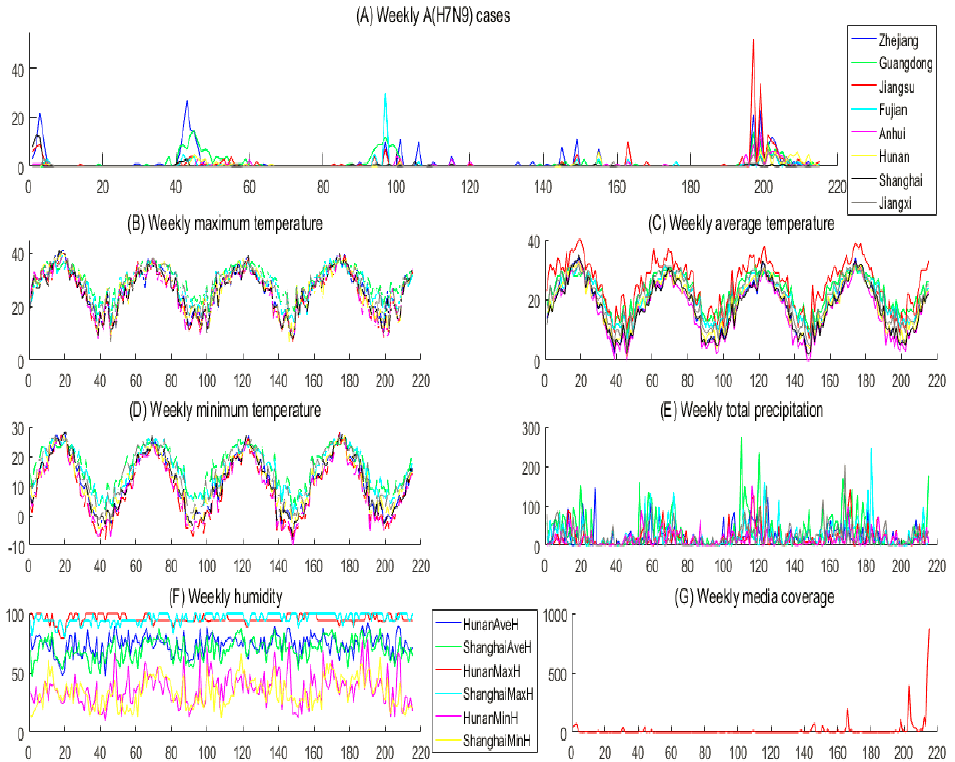
Figure 1. Time series plots of weekly reported human cases of A(H7N9), meteorological factors and media coverage from 31 March 2013 to 13 May 2017 for the provinces Zhejiang, Guangdong, Jiangsu, Fujian, Anhui, Hunan, Shanghai and Jiangxi. ( A ) Weekly reported human cases of A(H7N9); ( B ) weekly maximum temperature; ( C ) weekly average temperature; ( D ) weekly minimum temperature; ( E ) weekly total precipitation for Zhejiang, Guangdong, Jiangsu, Fujian, Anhui and Jiangxi; ( F ) maximum relative humidity, average relative humidity, minimum relative humidity for Hunan and Shanghai; and ( G ) the number of weekly news items relevant to A(H7N9).